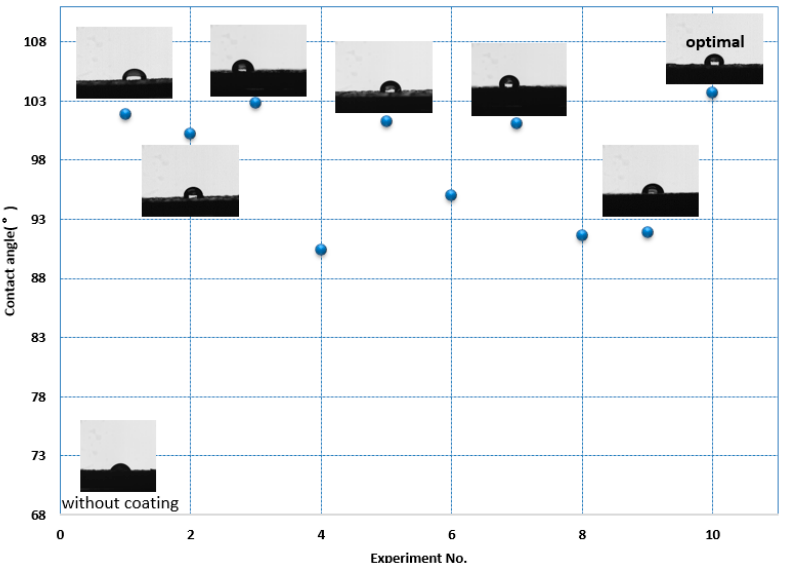
Figure 14. Contact angle of tested parts.